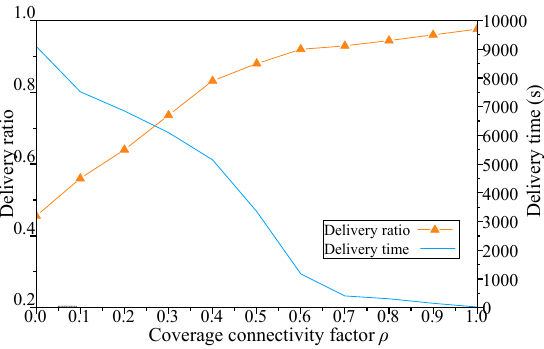
Figure 6. Influence of ρ on message delivery ratio and delivery time.